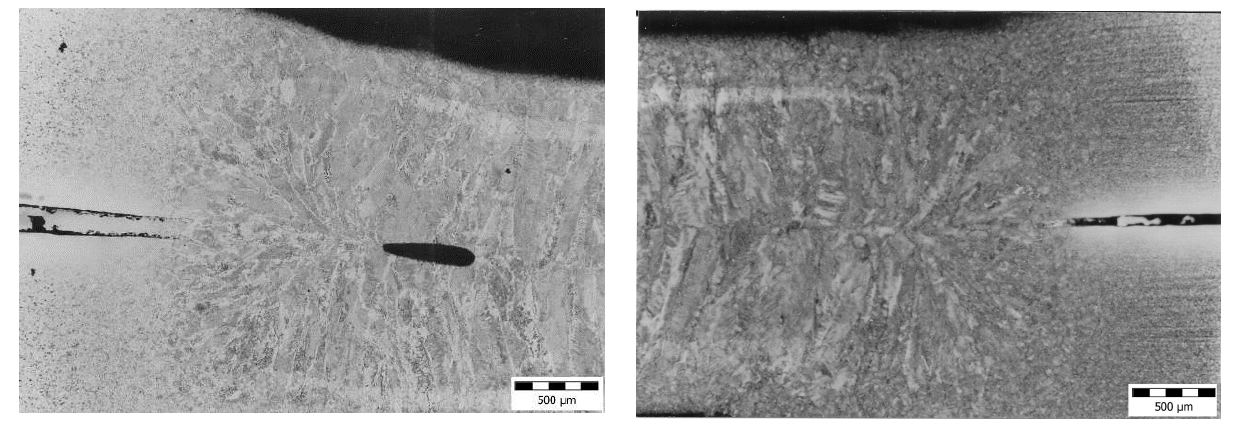
Figure 13: Weld nugget and heat affected zone of sample